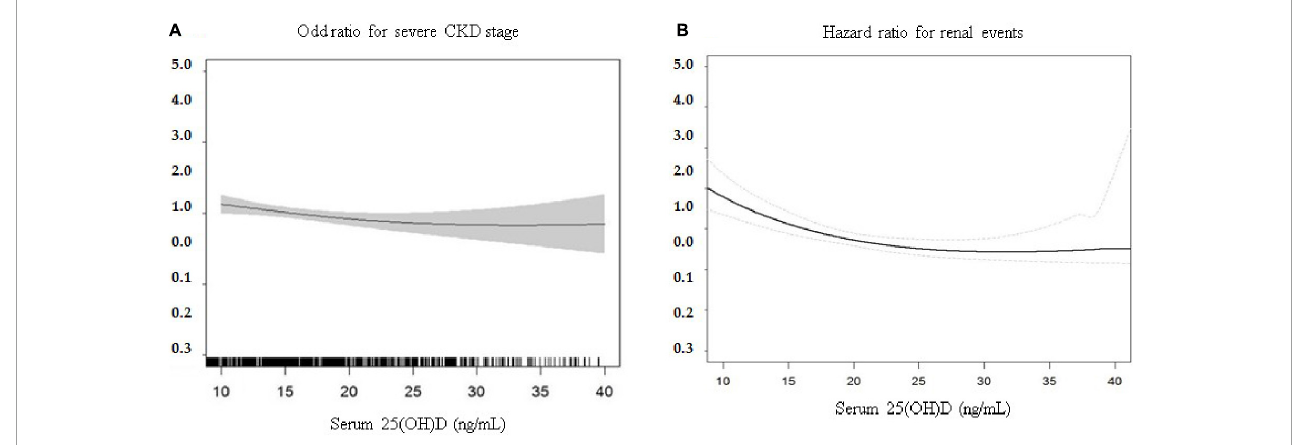
FIGURE1 Multivariate association of continuously measured 25(OH)D levels (ng/mL) and (A) severe CKD stages and (B) risk of renal events. The relationship between serum vitamin D levels (continuous scale) and risk of renal event were non-linear after multivariate adjustment. CKD, Chronic kidney disease; 25(OH)D, 25-hydroxyvitamin